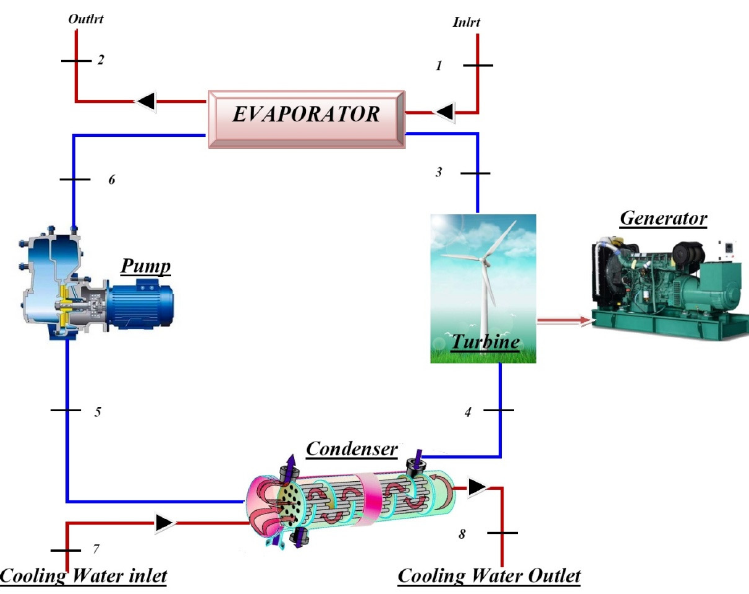
Figure 3. Schematic of the organic Rankine cycle.